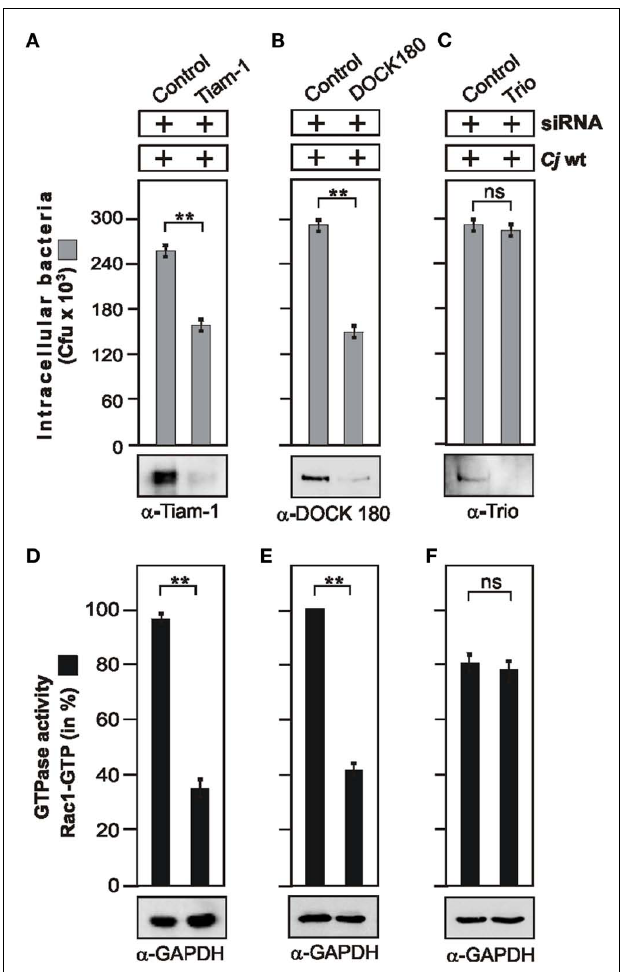
FIGURE 5 | Importance of guanine exchange factorsTiam-1, DOCK180, andTrio for C. jejuni -induced Rac1 activation and bacterial invasion. INT-407 cells were transfected with siRNA againstTiam-1 (A) , DOCK180 (B) , orTrio (C) , as well as a scrambled siRNA as control. After 48h, cells were infected withWT C. jejuni 81–176 for 6h. Intracellular bacteria were quantified by gentamicin protection assays. Immunoblotting with indicated antibodies confirmed successful knockdown of respective proteins.To detectTiam-1 expression, immunoprecipitation with α -Tiam-1 antibody was performed. GAPDH expression levels were determined as control. (D–F) The presence of bound, active Rac1-GTP was analyzed in CRIB–GST pull-down assays for each indicated GEF. Quantification of Rac1 GTPase activity during the course of infection. One hundred percentage of activity corresponds to the highest amount of detected GTPase-GTP level. ∗∗ p ≤ 0.005 was considered as statistically significant as compared to the